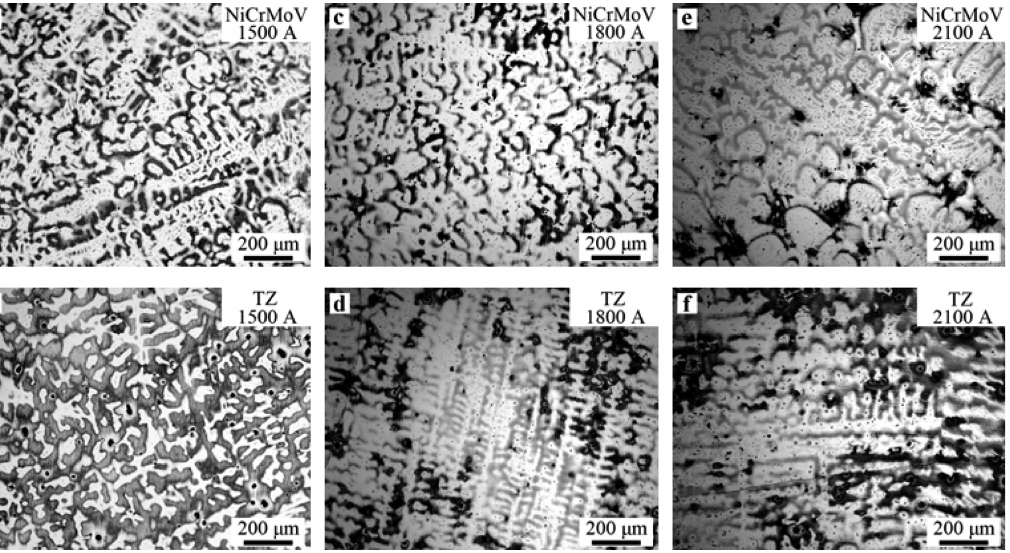
Figure 9: Optical microstructures of NiCrMoV zone and transition zone (TZ) in each dual alloy ingot processed by ESR with different currents.